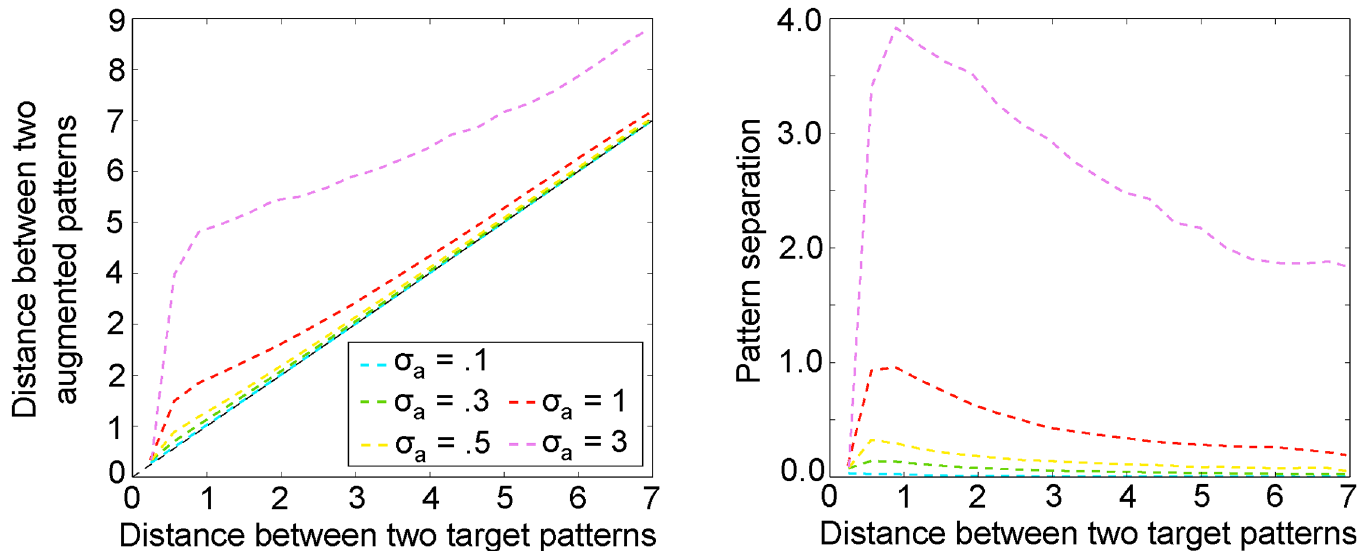
Fig 4. Augmentation with pattern separation vector leads to pattern separation. Left: The distance between pairs of augmented patterns ( D pattern separation vectors, against the distance between pairs of original patterns ( D t ). A curve above the diagonal means that the augmented vectors and more dissimilar than the original vectors, indicative of pattern separation. Right: Same data as left panel, but plotted to emphasize pattern separation (= D